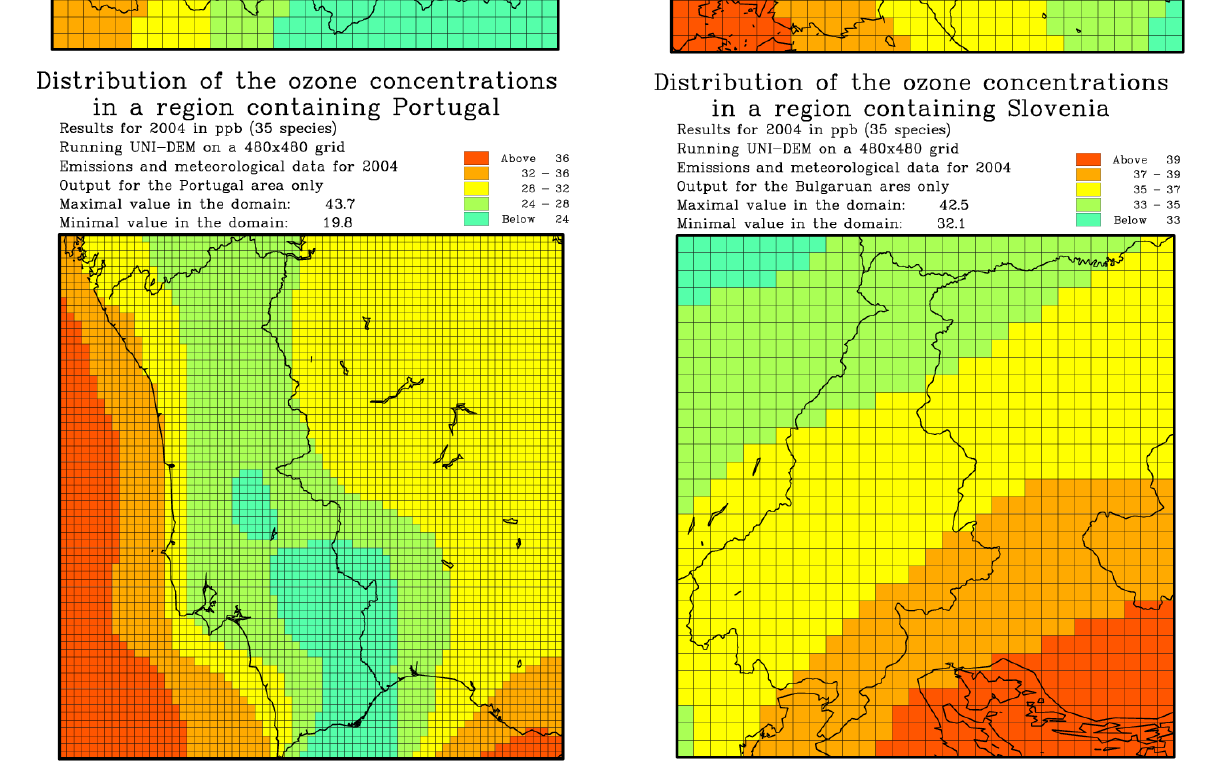
Figure 1. Mean ozone concentrations in four European countries (these plots demonstrate the ability of UNI-DEM to produce reliable results also for the small countries in Europe). The total number of (10 km × 10 km) grid-squares in the surface level is 230,400 . The model is normally run with a stepsize of 30 s. Runs performed over a time-interval of 16 consecutive years will be discussed in Sections 4 and 5 of this paper.